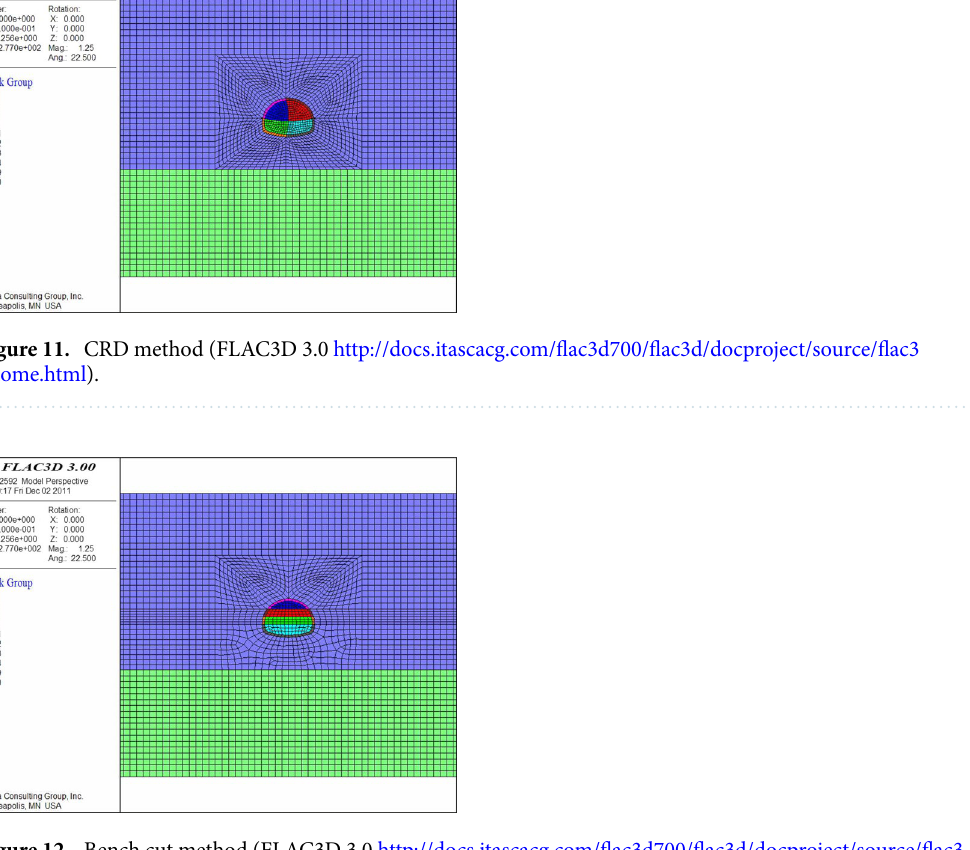
Figure 12. Bench cut method (FLAC3D 3.0 http:// docs. itasc acg. com/ flac3 d700/ flac3d/ docpr oject/ source/ flac3 dhome.